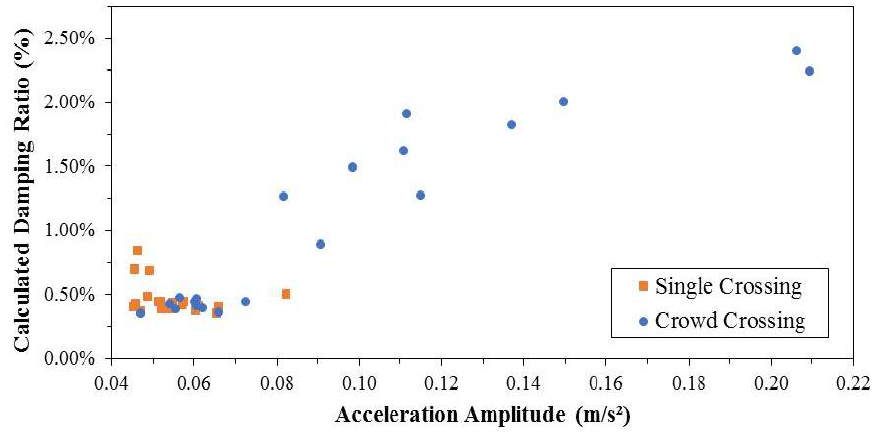
Figure 6. Damping ratios for the first structural mode.